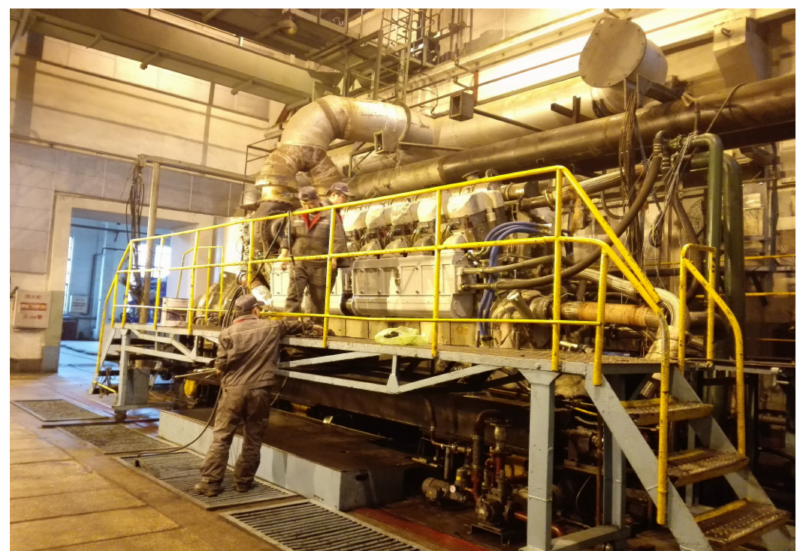
Figure 3. Picture of diesel engine bench